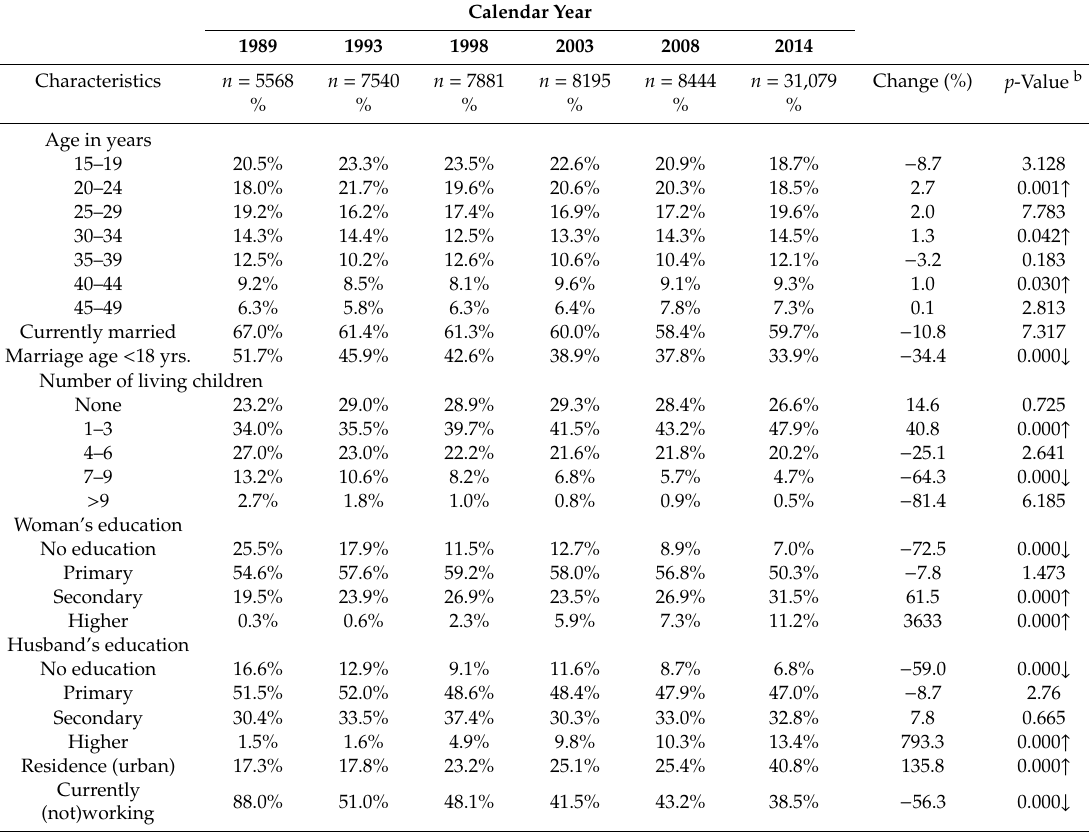
Table 1. Characteristics of women in reproductive age—Kenya Demographic Health Survey 1989–2014 (five year waves) (total n = 68,707) a